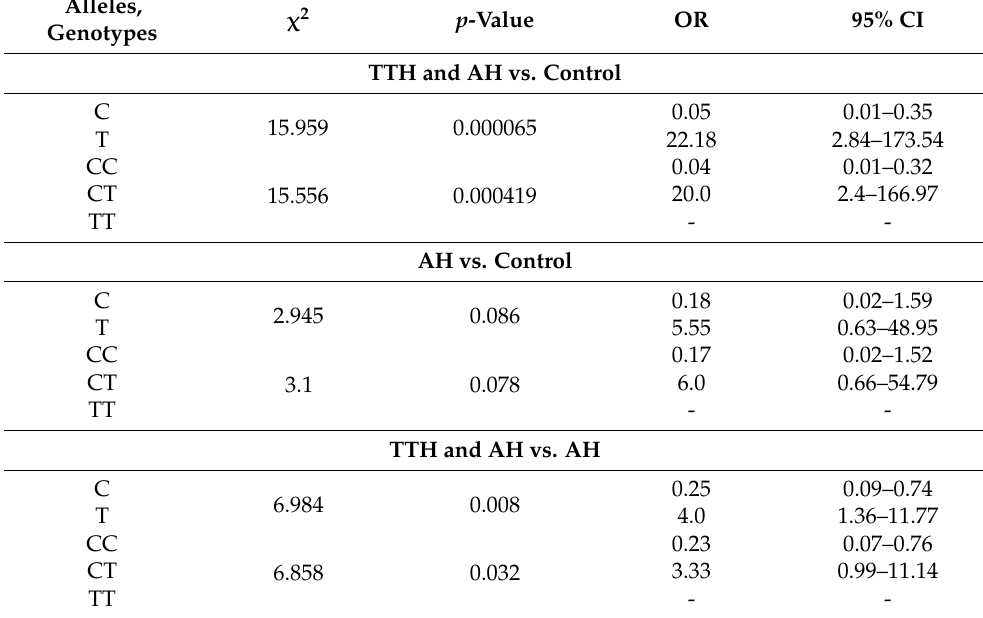
Table 3. Odds Ratio of tension-type headache and arterial hypertension overlap syndrome depending on minor or major alleles and genotypes of rs3782218 of the NOS1 gene.